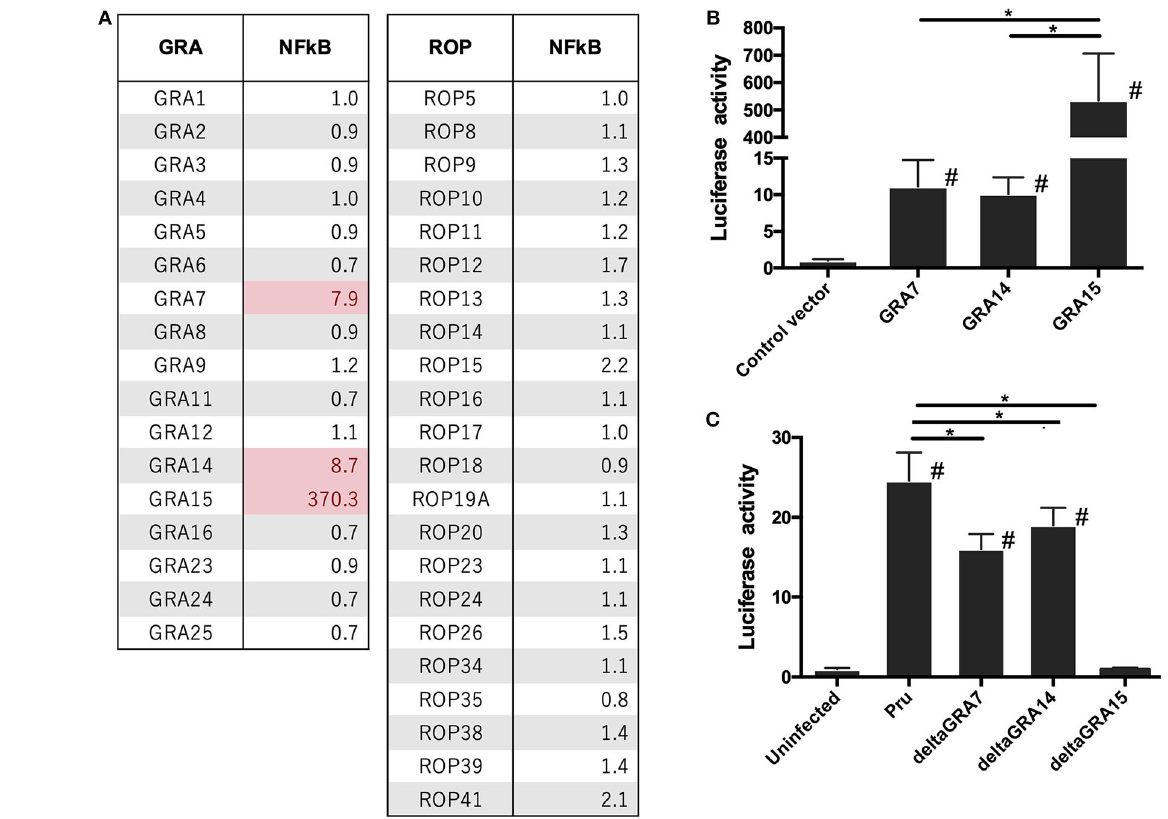
FIGURE 1 | Luciferase activities in 293T cells transfected with NF κ B reporter plasmid. 293T cells were transiently transfected with pGL4.32 expressing firefly luciferase and pGL4.74 expressing renilla luciferase. (A,B) Cells were immediately transfected with the expression vectors of GRAs and ROPs, and the empty p3 × FLAG-cmv14 vector used as a negative (empty) control. The promoter activity was determined and is shown as a fold-increase in the luciferase activity normalized for Renilla luciferase activity. (C) Pru, Pru 1 gra7 (deltaGRA7), Pru 1 gra14 (deltaGRA14), or Pru 1 gra15 (deltaGRA15) lines were added to the cells. After 12h, parasites were added to the host cells, lysates were prepared, and luciferase activity was measured. The promoter activity was determined and is shown as a fold-increase in the luciferase activity normalized for Renilla luciferase activity. Values are the means ± SD of triplicate samples, * p < 0.05. #a significant difference with the control vector and or uninfected cells ( p < 0.05). Differences were tested by one-way ANOVA with turkey’s post-hoc test in (B,C) . Data are representative of two independent